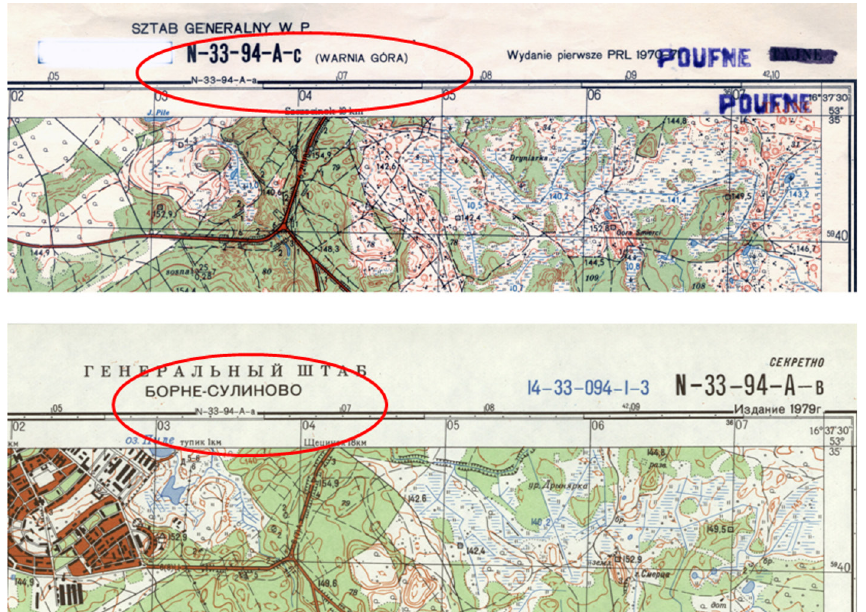
Fig. 8. Removed name of the Polish topographic map 1:25,000 sheet Borne Sulinowo. The barracks were completely camouflaged on the Polish map, and the relief on the Soviet one was excessively